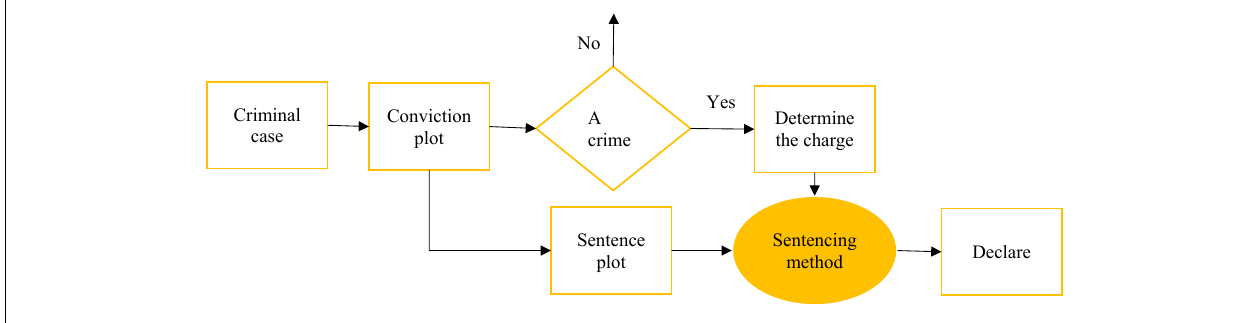
FIGURE 8 | The conversion of the remaining constitution of the crime fact for conviction.